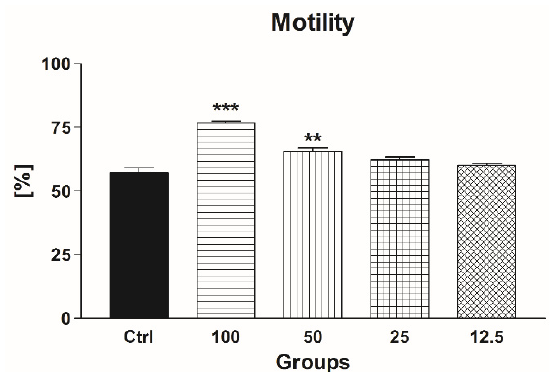
Figure 6. The e ff ect of epicatechin (EPI; µ mol / L) on the motility of frozen-thawed bovine spermatozoa. Figure 6. The effect of epicatechin (EPI; μ mol/L) on the motility of frozen-thawed bovine * p < 0.05; ** p < 0.01; *** p < spermatozoa. * p < 0.05; ** p < 0.01; *** p < 0.001.